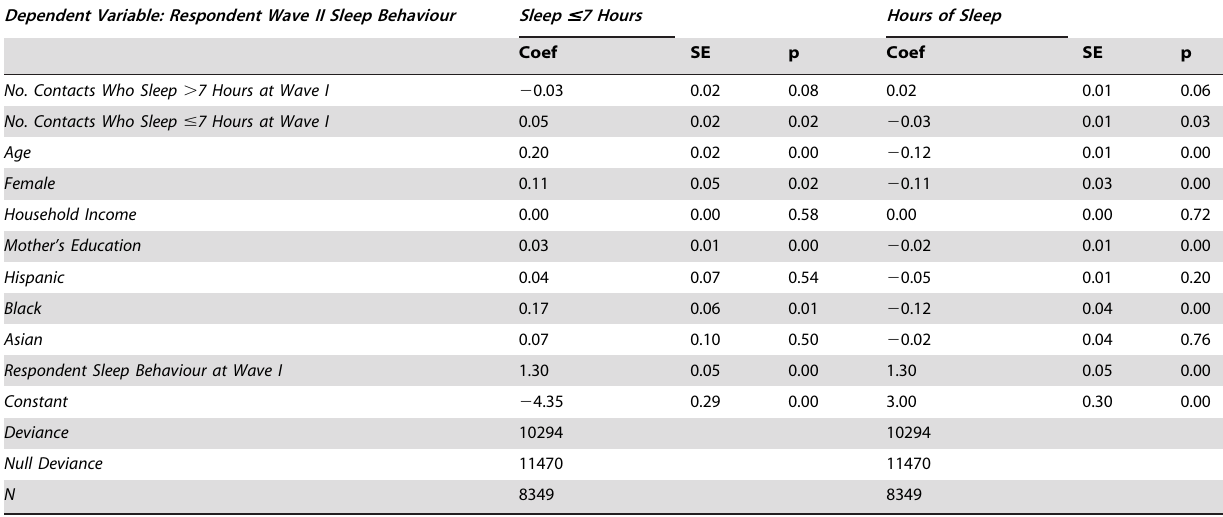
Table 1. Sleep and social